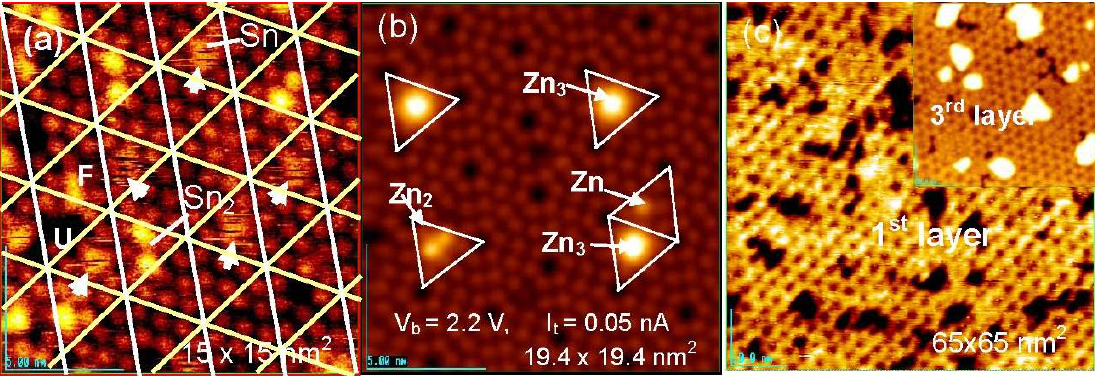
Figure 18. Sn and Zn atoms deposited on a clean Si(111)-7 × 7 surface at room temperature; ( a ) Fuzzy image indicates a rapidly migrating Sn-atom in a half unit cell. When a 2nd Sn atom comes in a half unit cell, migration of Sn atoms stops [62]; ( b ) Initial stage of deposited Zn, Zn and Zn localized on the center Si-adatoms; ( c ) Honeycomb 2 3 over-layer composed of Zn -cluster formed on a Si(111)-7 × 7 surface. An inset 3